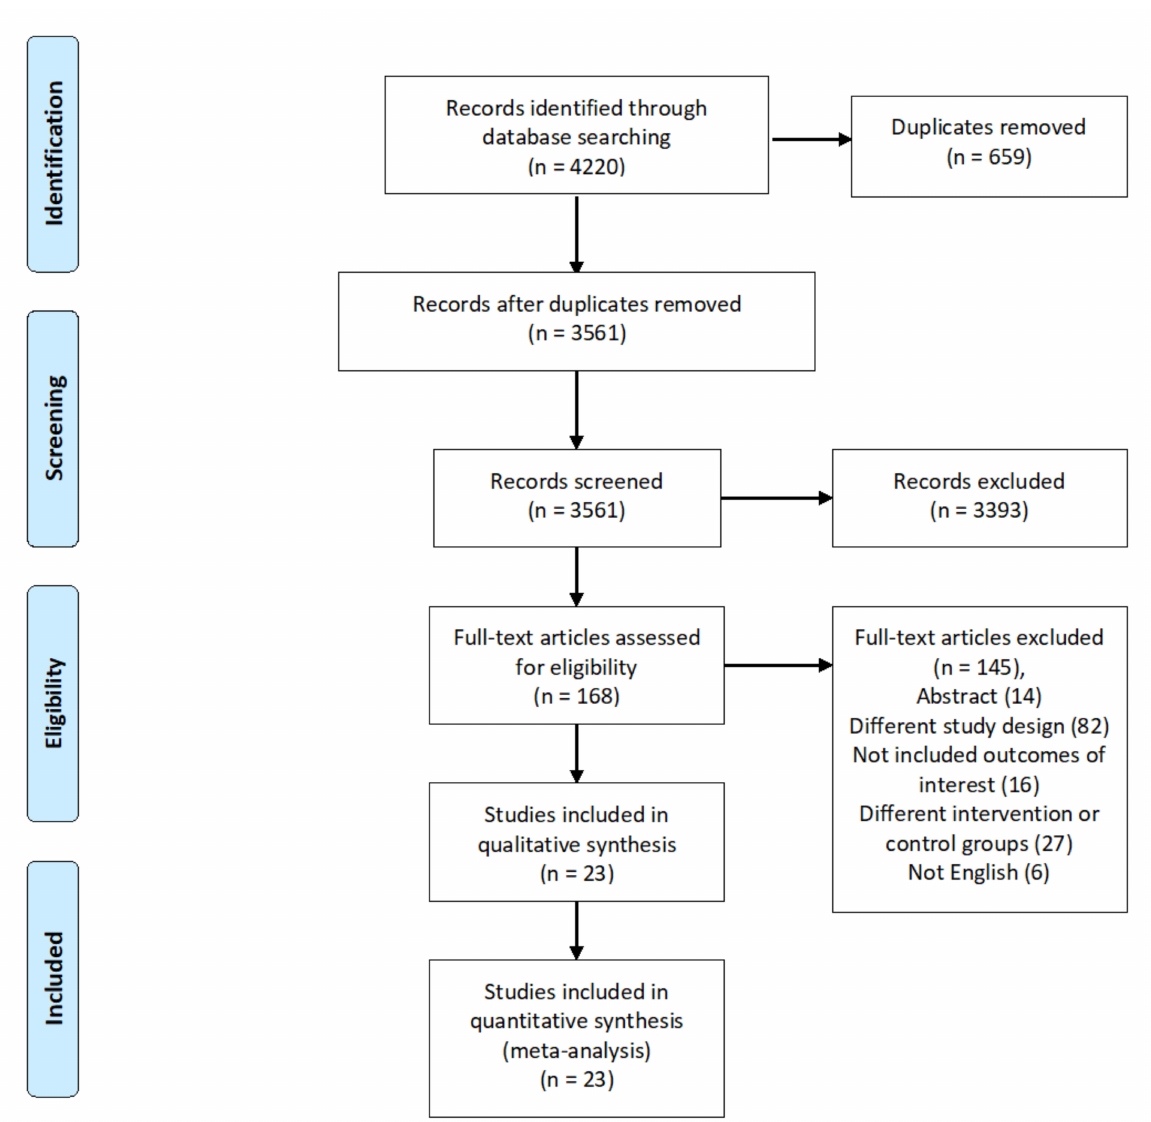
Figure 1. The figure shows the PRISMA flow diagram. All the studies were RCTs. The countries included Spain, Brazil, the USA, Turkey, and others. The interventions included acupuncture, lidocaine, fluoxetine, physiotherapy, nutraceutical, (Inflammatory Gut–Brain Axis Control) (IGUBAC)-Diet, weight reduction, olive tree-based food supplement, transcutaneous electrical nerve stimulation (TENS), cupping, and sham/placebo. The total sample size was 1409 patients. The majority of the included patients were females, see Table